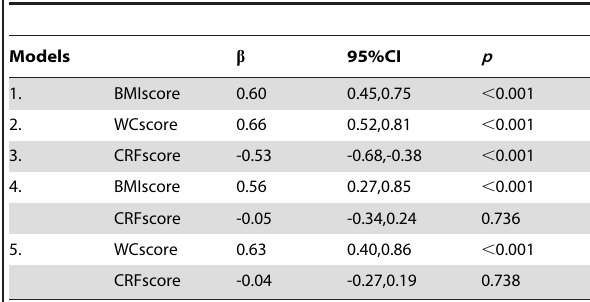
Table 2. Multivariate linear regression examining the associ- ations between BMI, WC, fitness and metabolic risk score.